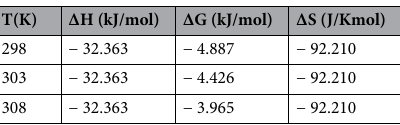
Table 6. Thermodynamic parameters of Cibacron blue biosorption on Bean peel (BP).